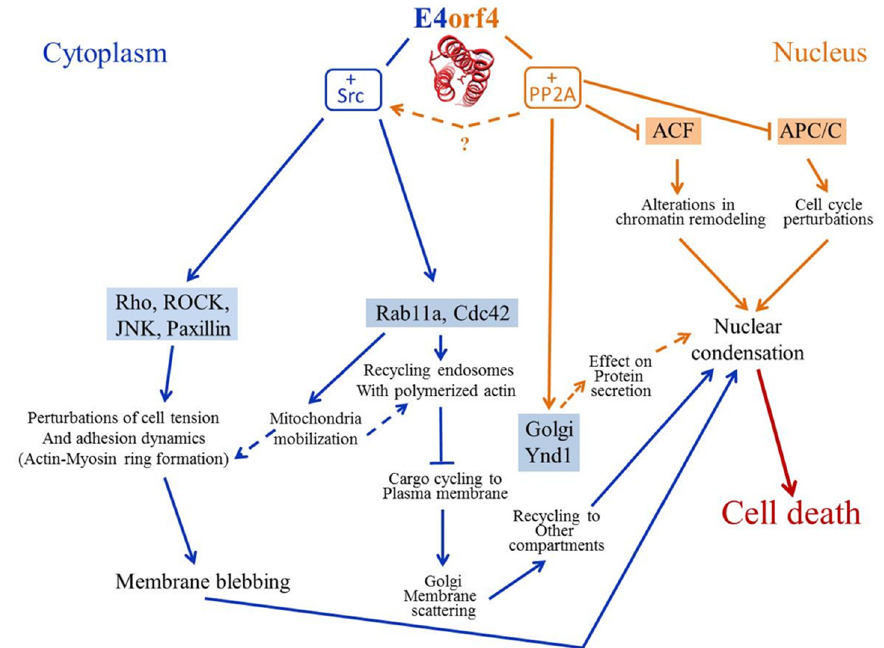
Figure 4. An integrated model of the mechanisms underlying E4orf4-induced cell death. E4orf4, in collaboration with its partners, PP2A and Src, induces alterations in the nucleus (chromatin remodeling, perturbations in cell cycle regulation) and in the cytoplasm (actin remodeling, changes in protein and membrane trafficking, changes in mitochondria morphology and mobilization), which result in blebbing, nuclear condensation and cell death: see the text for details. Arrows representing PP2A-dependent signaling are marked in orange and arrows showing Src-dependent signaling are marked in blue. Nuclear effectors are highlighted in orange and non-nuclear effectors are highlighted in blue. Connections in the E4orf4 network that were suggested but not proven yet are shown by discontinuous arrows. E4orf4 is represented by a structural model containing three alpha-helices